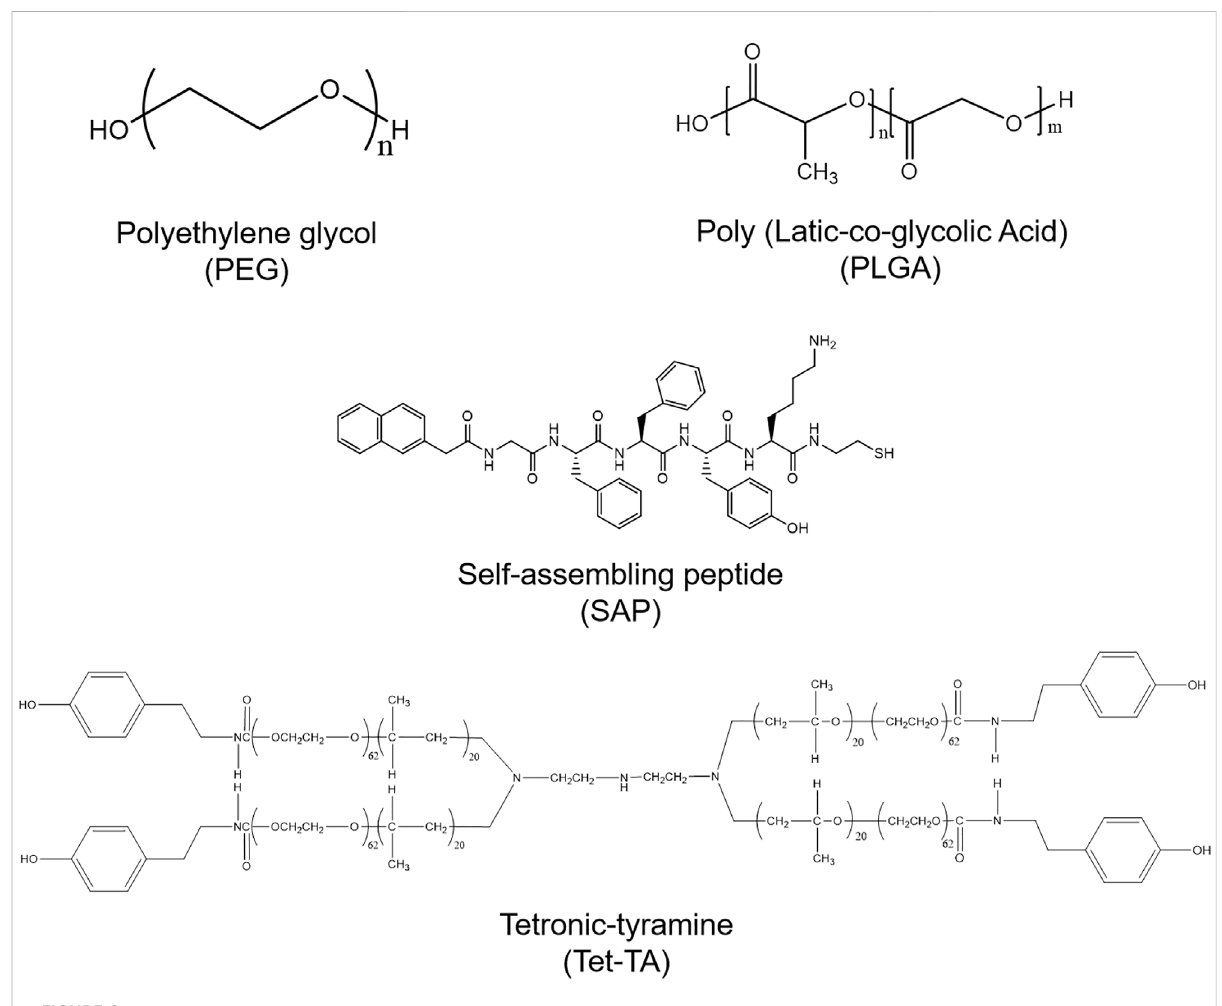
FIGURE 8 The structures of synthetic materials for preparing